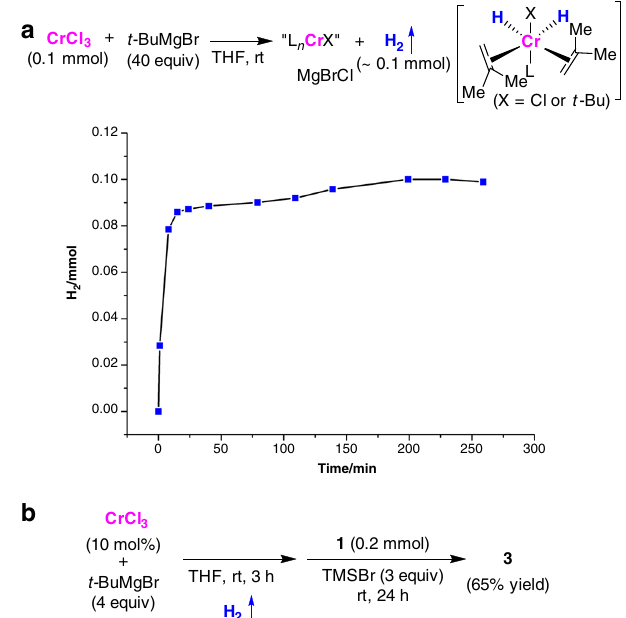
Fig. 4 The formation of low-valent chromium species in situ for the para - selective alkylation. a Hydrogen evolution by the reaction of CrCl 3 with t - BuMgBr. b para -Selective alkylation of benzamide that was promoted by